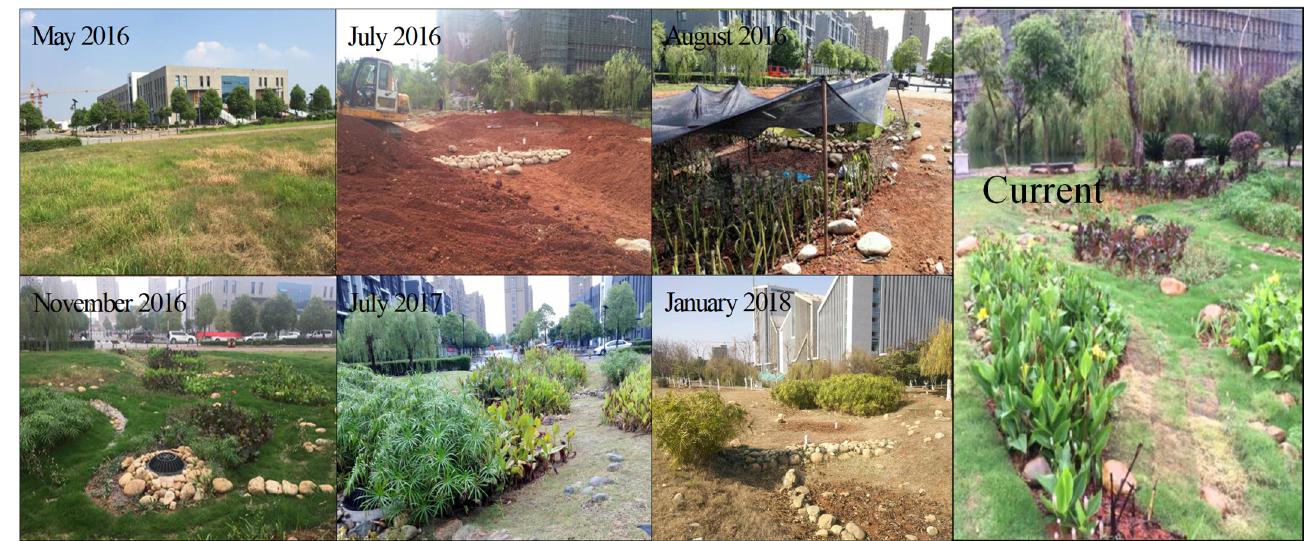
Figure 2. Pictures of the rain garden before, during and after construction.